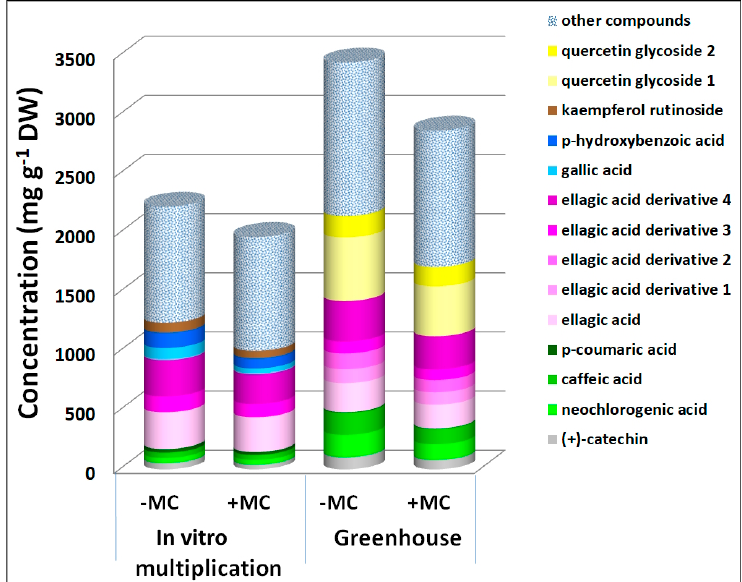
Figure 3. Concentrations of phenolic compounds in the aboveground part of strawberry cv. ‘Solnechnaya polyanka’ plants contributed to the downregulation of the total phenolic content under the influence of the MC during in vitro multiplication and greenhouse growth. Abbreviations: MC, mechanocomposite; − MC, mechanocomposite free; +MC, mechanocomposite treatment; DW, dry weight.